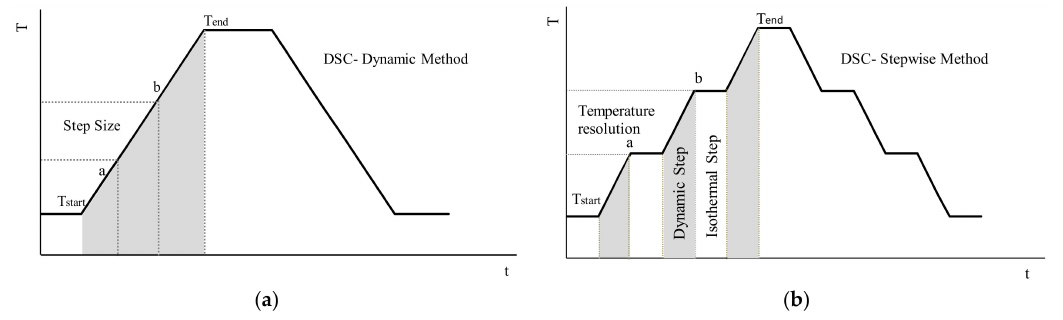
Figure 3. T(t) program for ( a ) dynamic DSC method and ( b ) stepwise DSC method.